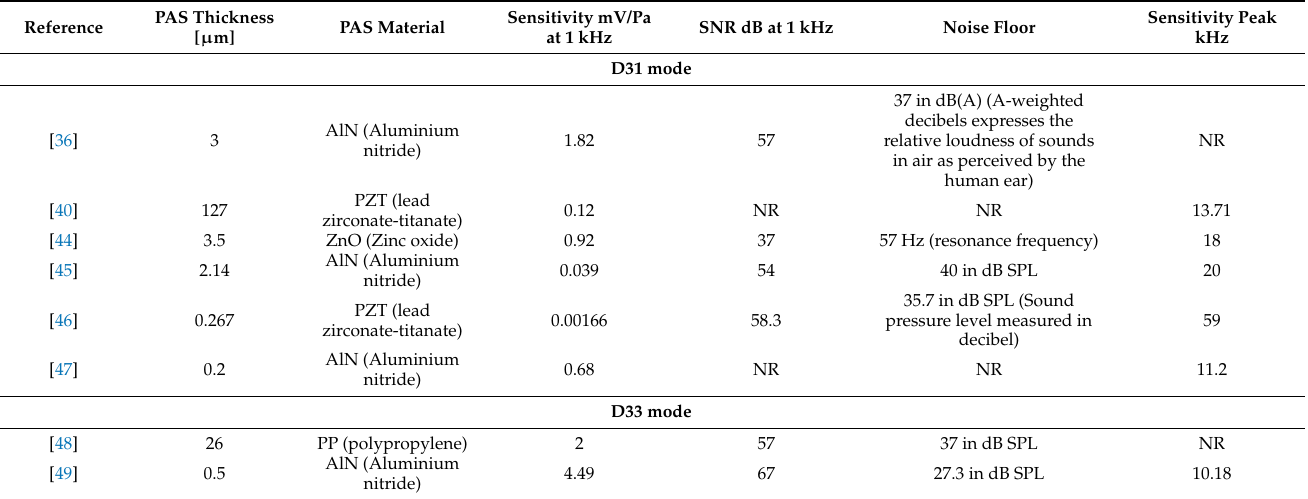
Table 2. References on D31 and D33 piezo acoustic sensors and the relative achieved values. NR: Not